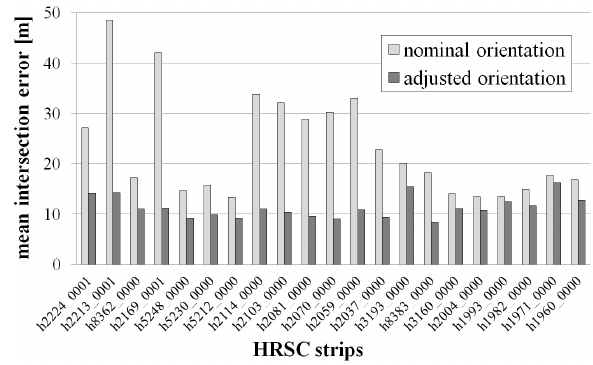
Figure 7: Mean intersection error before and after single strip bundle adjustment